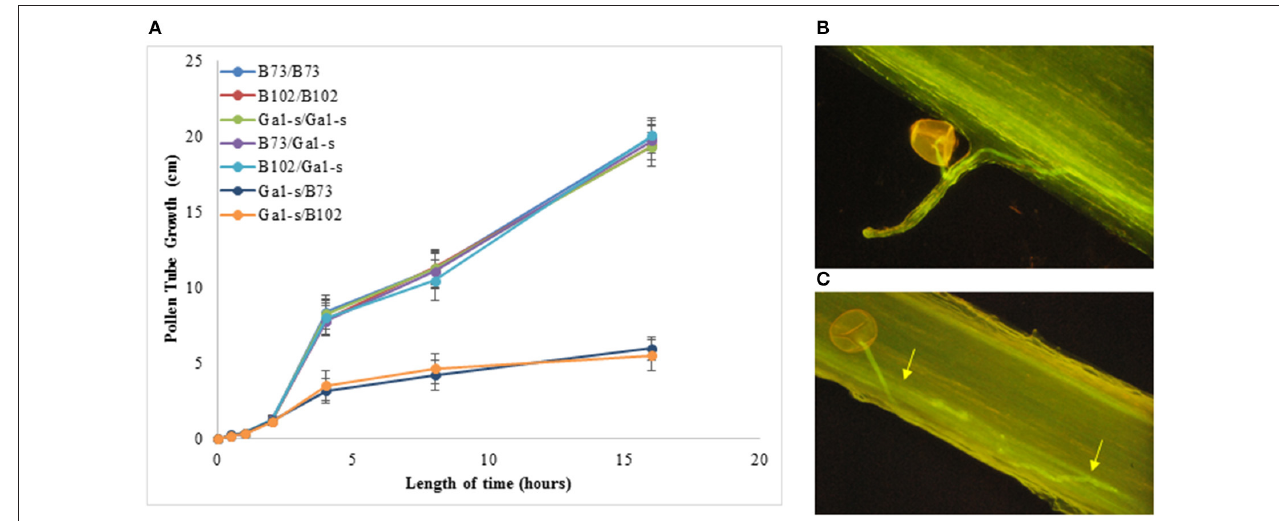
FIGURE 1 | Pollen tube growth in compatible vs. incompatible pollinations. Pollen tubes from compatible and incompatible pollinations were fixed and stained with aniline blue at fixed times after pollination (A) Length of pollen tubes over time in compatible vs. incompatible pollinations. Error bars represent the standard deviation for three independent experiments. (B) Aniline blue staining in vivo of pollen tubes in a compatible pollination. Pollen tubes grow straight once inside the transmitting tract (40X magnification). (C) Aniline blue staining in vivo of pollen tubes in an incompatible pollination. Incompatible pollen tubes do not grow straight and are sometimes seen exiting and reentering the transmitting tract